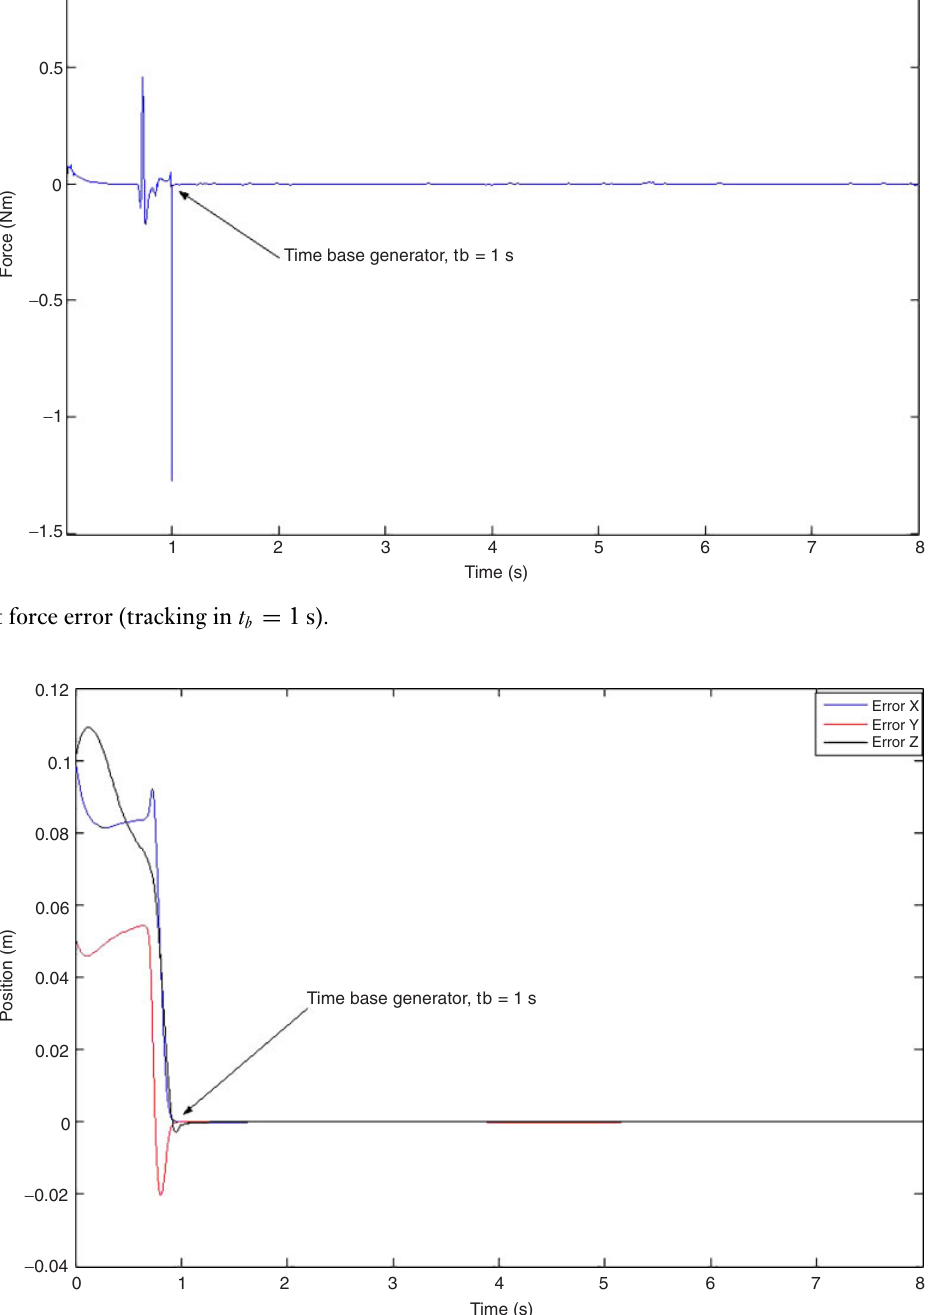
SIMULATIONS Desired Cartesian trajectories